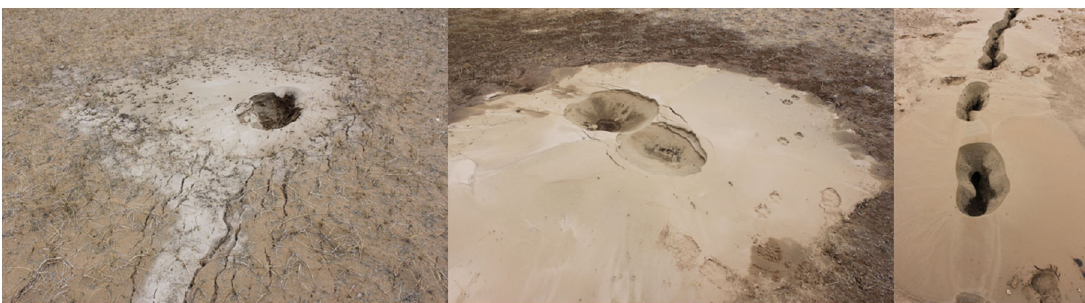
Figure 16. The photos of liquefaction pits near the epicenter induced by the Maduo earthquake. Third, the proposed methods had good performance regarding the Maduo